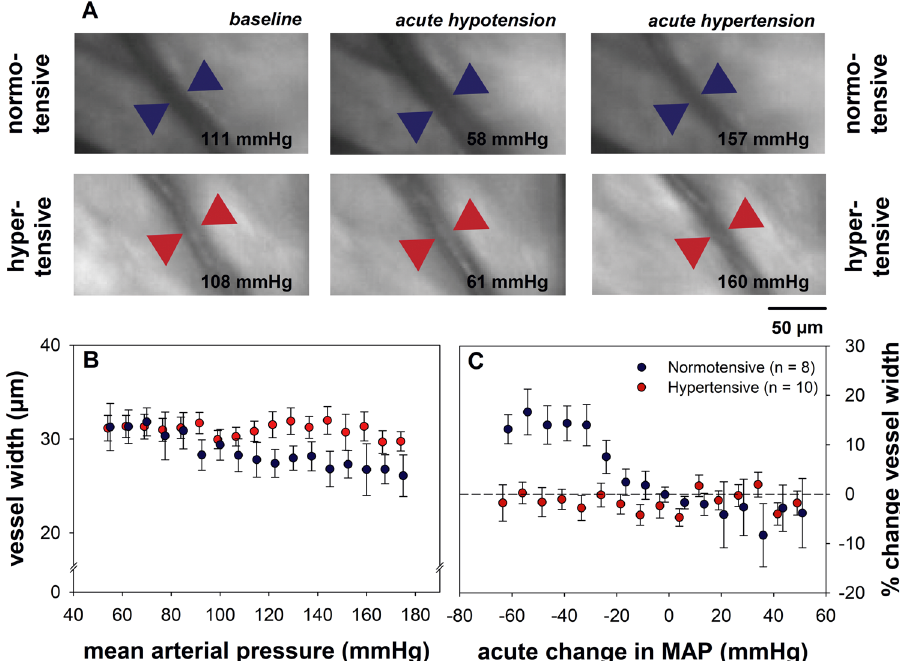
Figure 1. Effect of chronic hypertension on retinal blood vessel reactivity during acute BP manipulation. ( A ) Representative arterioles from a normotensive rat (blue arrowheads) and a hypertensive rat (red arrowheads) during BP manipulation procedure. The normotensive rat shows vasodilation relative to baseline during acute hypotension, and vasoconstriction during acute hypertension. The hypertensive rat show minimal change in vessel diameter. The mean arterial pressure at the time of blood vessel imaging is shown in the bottom right corner of each image. ( B ) Average arteriole width (mean ± SEM) in response to acute BP manipulation. ( C ) Change in arteriole width (mean ± SEM) from baseline as a function of change in MAP from baseline. The interaction between BP group and vasodilation was significant at changes in MAP from baseline between − 70.0 and − 32.5